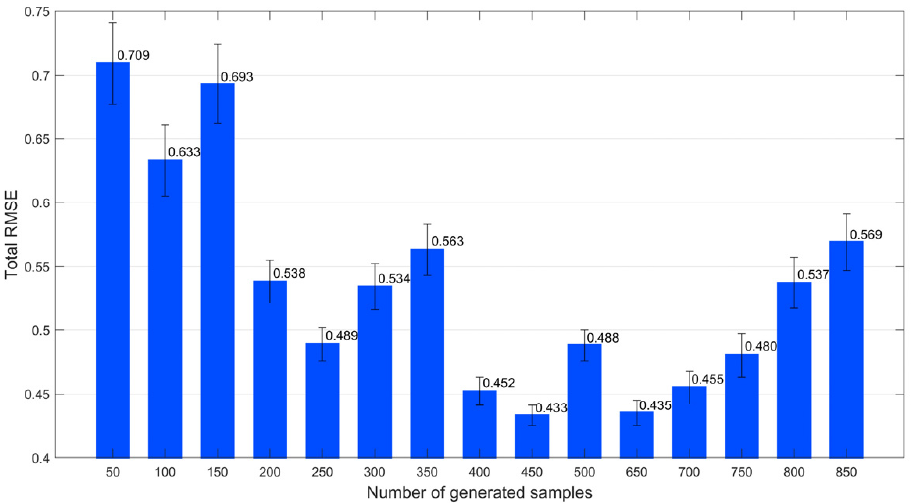
Figure 4. Total RMSE values of the different numbers of generated samples for the numerical example. The scatter distributions of the original samples and the 450 generated samples are presented in Figure 5a. Several unsuitable samples did not conform to the initial data distribution. According to the proposed S1 and S2 data selection criteria, the scatter distribution of the qualified virtual samples, rough virtual samples, and initial limited samples are shown in Figure 5b. Unsuitable samples that were too close to the centroid and distant outliers were filtered. Consequently, the qualified virtual samples matched the distribution of the original samples. When combined with the original training data, the qualified virtual samples served as complements to the initial samples. The SWGAN- SVR model was built, based on the qualified augmented training samples; the prediction results for the test set are listed in Table 1. For comparison, the prediction results of SVR, WGAN-SVR, and WGAN-SVR using the S1 criterion (denoted as WGAN-SVR(S1)), and WGAN-SVR using the S2 criterion (denoted as WGAN-SVR(S2)), are also listed in Table 1. WGAN-SVR, WGAN-SVR(S1), WGAN-SVR(S2), and SWGAN-SVR outperformed the SVR method, with smaller RMSE and MAE values and larger R 2 values. This is mainly because the generated samples increased the diversity of the training samples. The